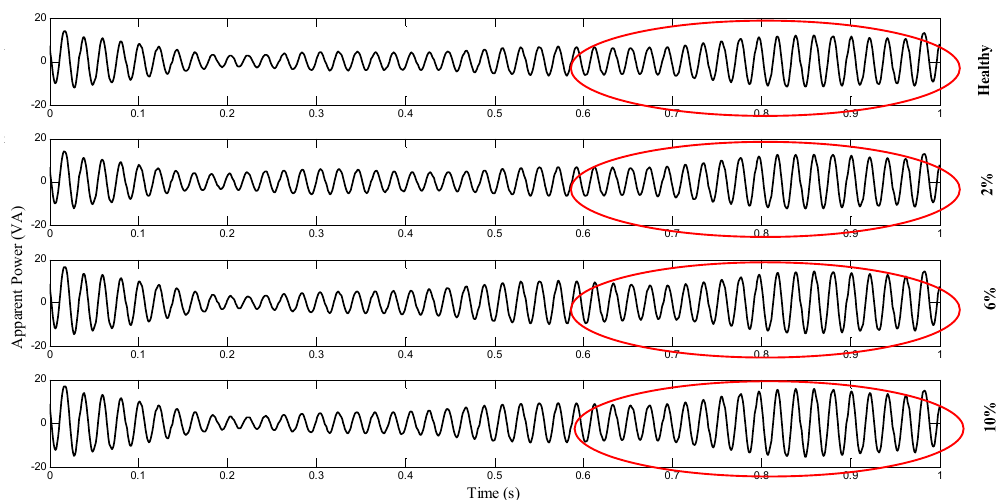
Figure 10. The characteristic time-domain signals of apparent power at no load under different levels of DE.